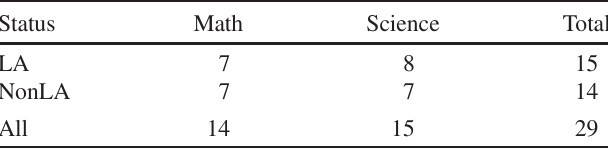
TABLE I. Count of teachers participating in the